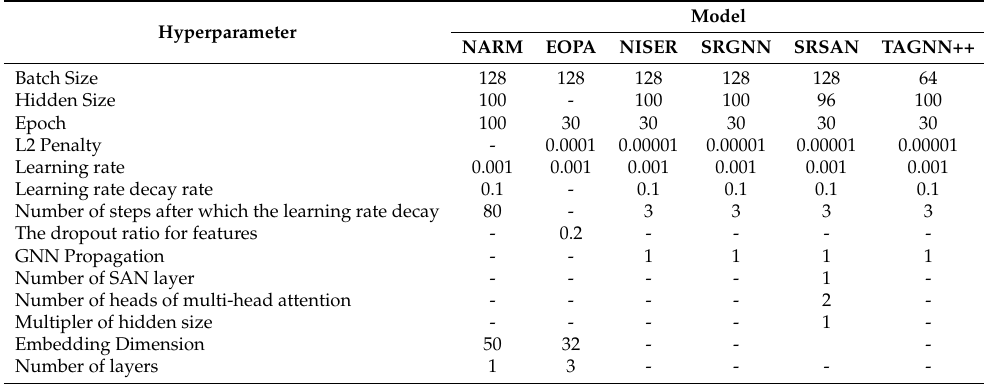
Table A2. The hyperparameter settings of six baseline